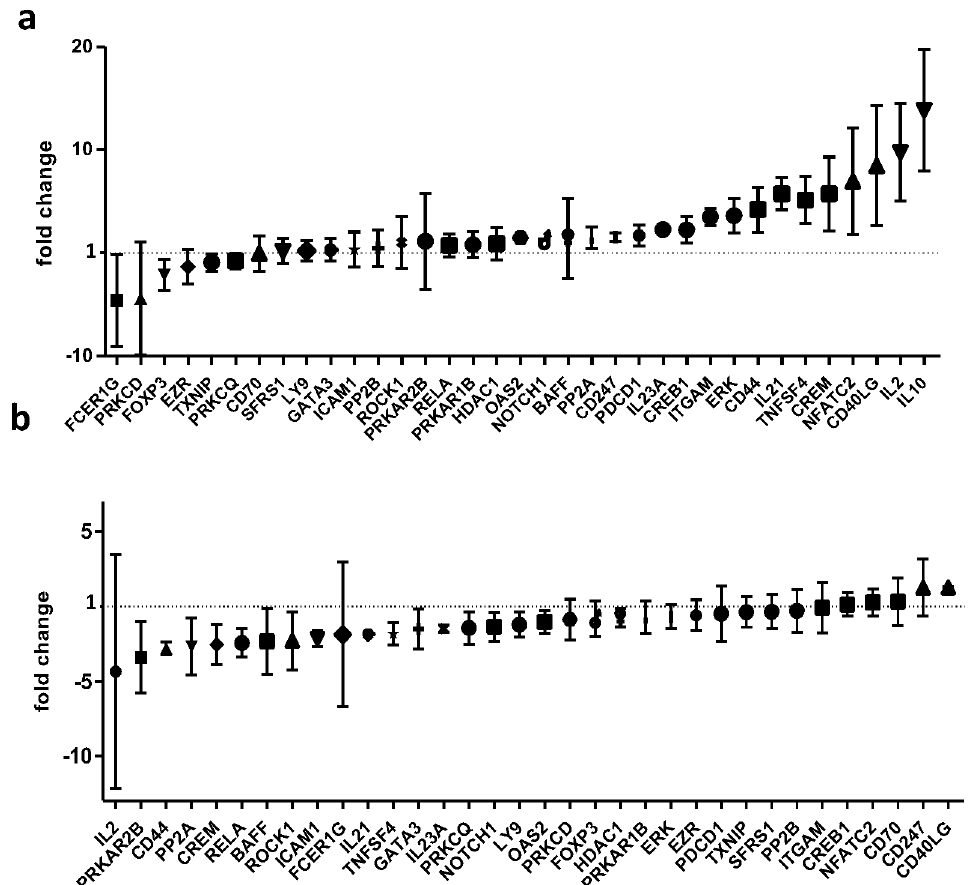
Figure 2. Intracellular levels of Syk affect the expression of genes associated with SLE immunopathogenesis. a) Healthy blood donor T cells were transfected with a SYK overexpression plasmid and the expression of an array of genes associated with SLE immunopathogenesis was measured using real-time PCR. A number of genes known to be overexpressed in SLE patients were found to be upregulated by SYK overexpression, like IL-21, CD44, OAS2 and PP2A (mean ±SEM fold expression changes between overexpression and empty vector transfected cells in four different experiments are shown). b) SLE patient T cells were transfected with either a SYK-specific siRNA or a control, non-silencing, siRNA. Silencing of SYK resulted in suppression of expression of a number of genes known to be aberrantly upregulated in SLE. Notably, expression levels of IL-21, CD44, OAS2 and PP2A were all found to decrease in SYK-knockdown T cells (mean ±SEM fold expression changes between silencing and control transfected T cells in four different experiments are